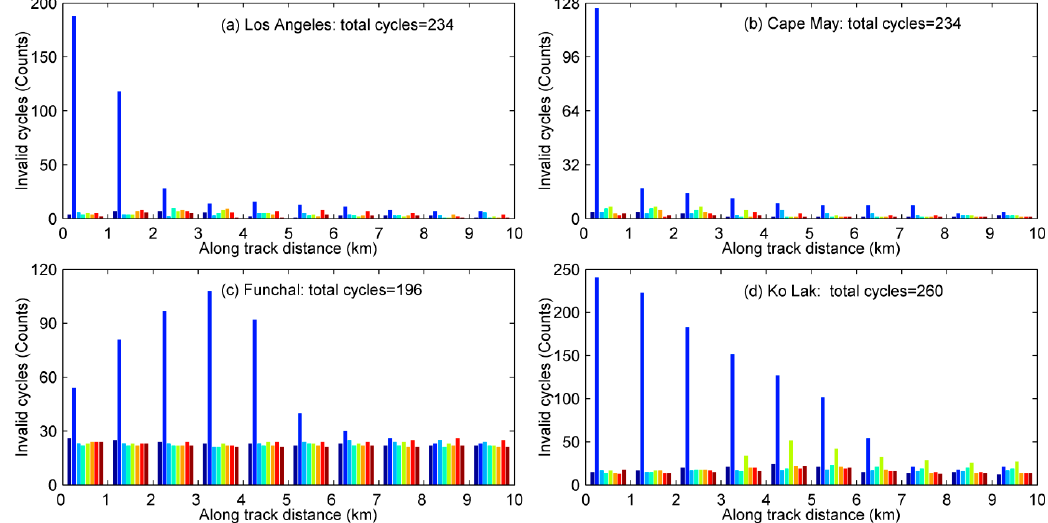
Figure 7. Invalid cycles for different retrackers over each 1-km band within 10 km offshore in four study regions: ( a ) Los Angeles, ( b ) Cape May, ( c ) Funchal, ( d ) Ko Lak. Color legend is the same as Figure 4.